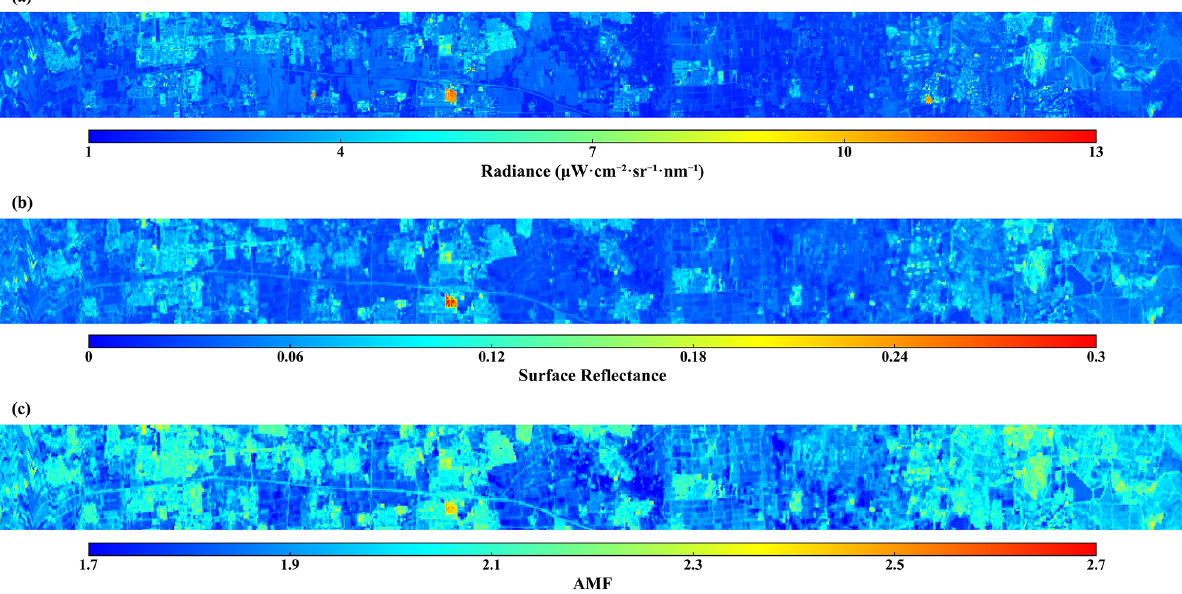
Figure 9. (a) UVHIS measured radiance; (b) Landsat 8 surface reflectance; (c) computed AMFs for one flight line of the Feicheng data set. A strong dependency of the AMF on the surface reflectance can be